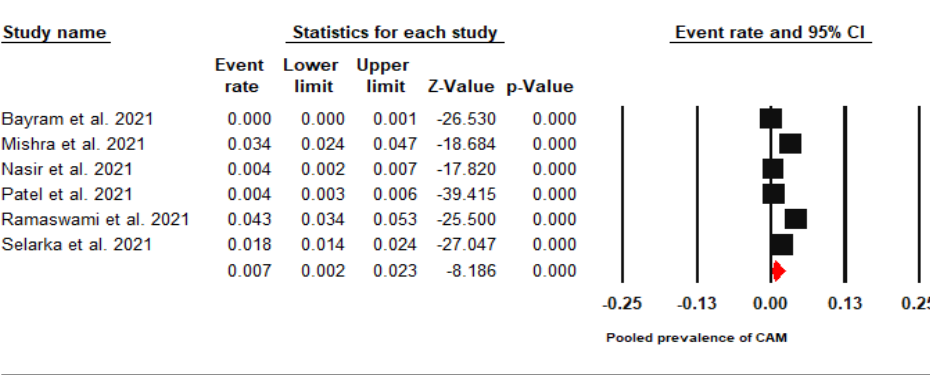
Figure 2. Forest Plot of the Pooled Global Prevalence of CAM.